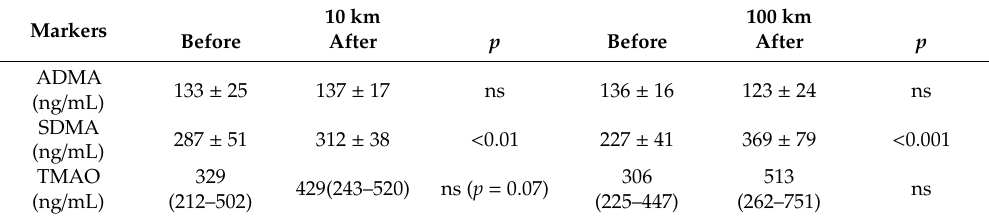
Table 6. Changes in ADMA, SDMA and